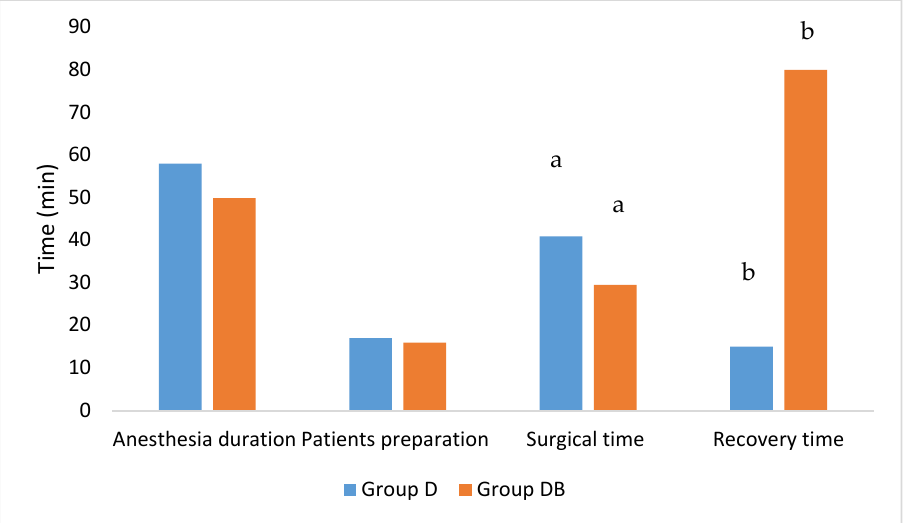
Figure 1. Vertical bar chart showing anaesthesia duration, patient preparation, surgical time and recovery time in the two groups. All the variables are expressed in function of time (minutes on the Y axis). Statistical differences are expressed by the same letter on the bars (a: p = 0.016; b: p = 0.003).